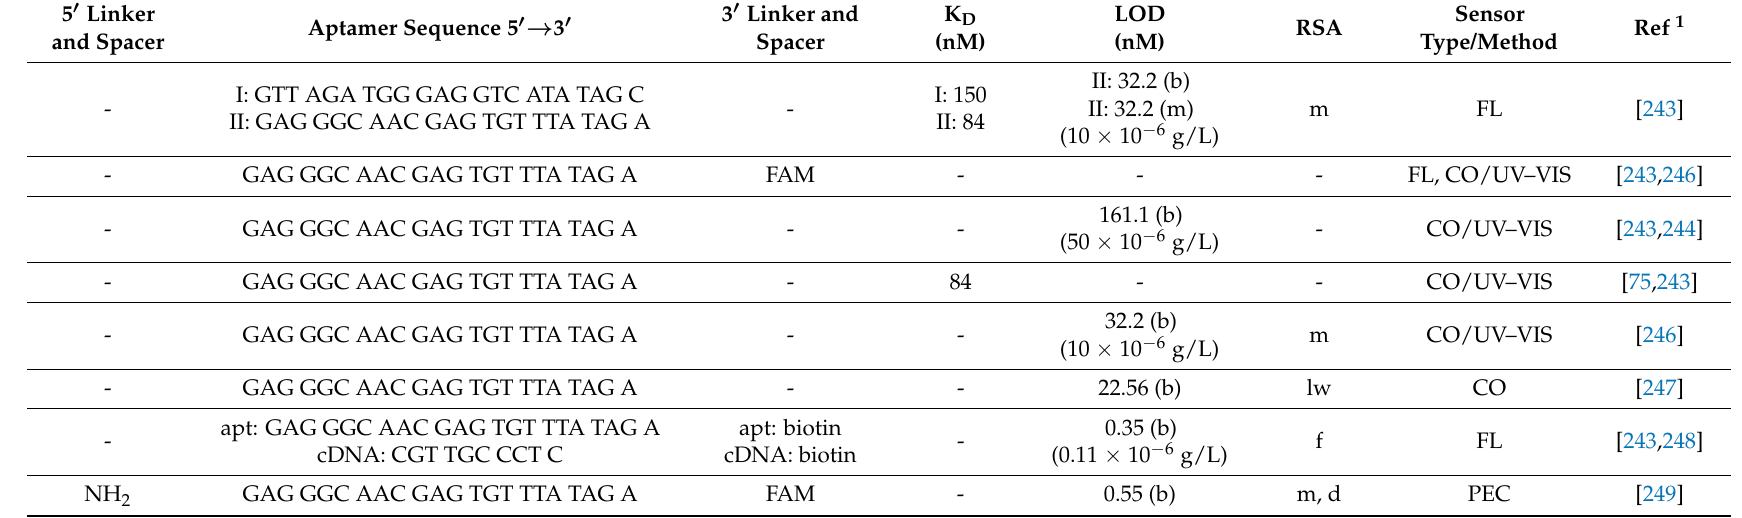
Table 17. Aptamer sequence, dissociation constant (K D ), limit of detection (LOD), real sample analysis (RSA), and realized sensor type and measuring method for sulfadimethoxine, mentioned in the corresponding references (Ref). apt = aptamer, b = buffer, cDNA = complementary DNA, CO = colorimetric, d = drugs, f =